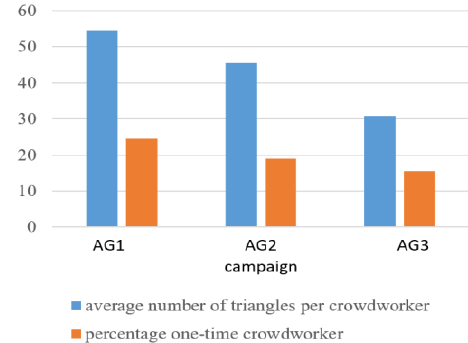
Figure 9. Average number of labelled triangles per crowdworker compared to percentage of one-time